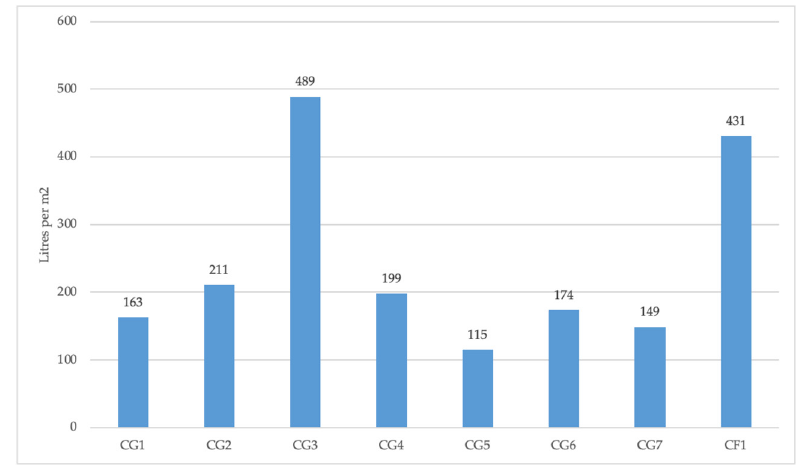
Figure 4. Water use in 2019 per site.